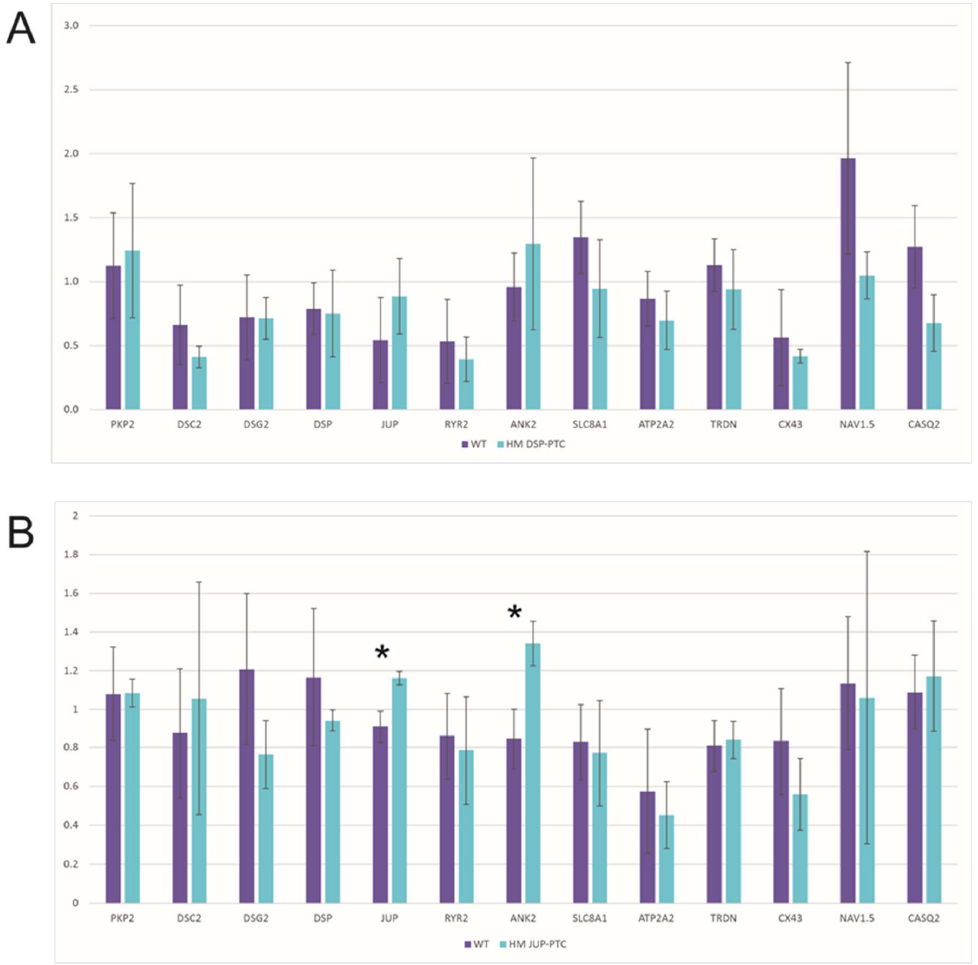
Figure 4. mRNA expression level of desmosomal, calcium handling and connexome genes in ( A ) HM DSP-PTC and ( B ) HM JUP-PTC clones. * Marks those gene expression levels that were significantly different between WT and edited clones.